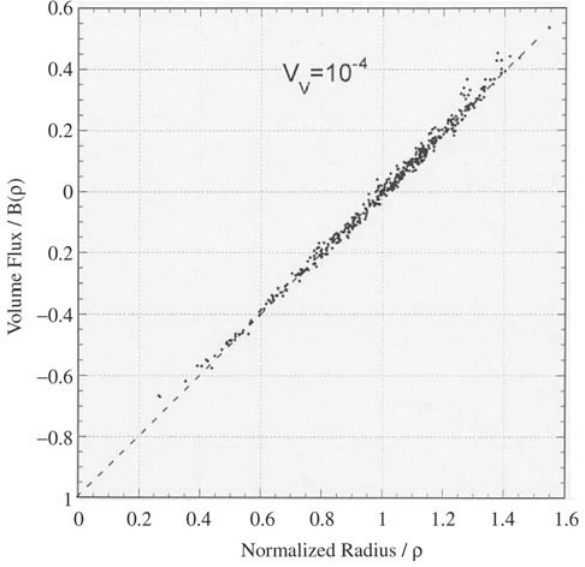
Figure 7. Volume flux per steradian, B( ρ ), versus scaled particle radius, ρ . Data are simulated from the multiparticle diffusion model =10 -4 . for a microstructure with a dispersoid volume fraction V V Note that the noise band continues to broaden when compared to the simulation data shown in Fig. 6, and that the fluctuations are noticeably asymmetrical with respect to the linear LSW predic- tion (dashed line). Broadening of locale noise is especially evident for larger